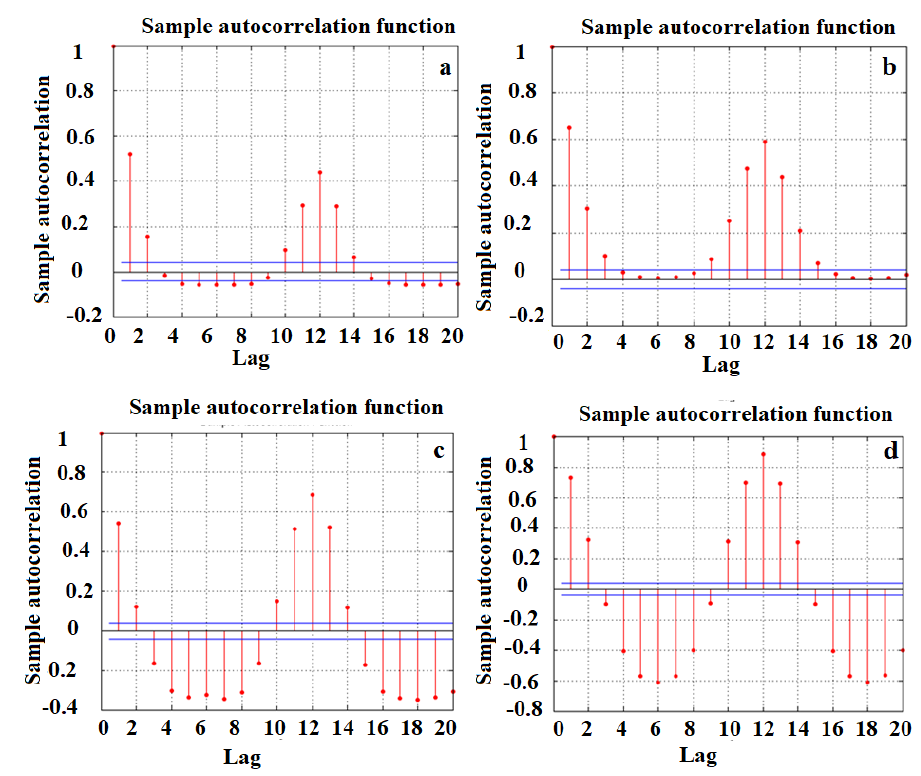
Figure 5. The autocorrelation function (ACF) for monthly hydro-climatical data ( a ) SL, ( b ) WD, ( c ) RF, ( d ) T.